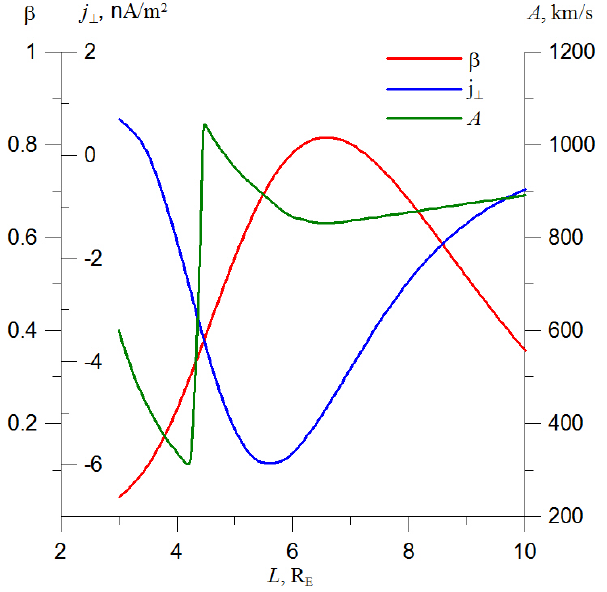
Fig. 6. Dependence of k 2 k (in R − 2 ) on geomagnetic latitude θ and E parameter L = r/R E for the fundamental